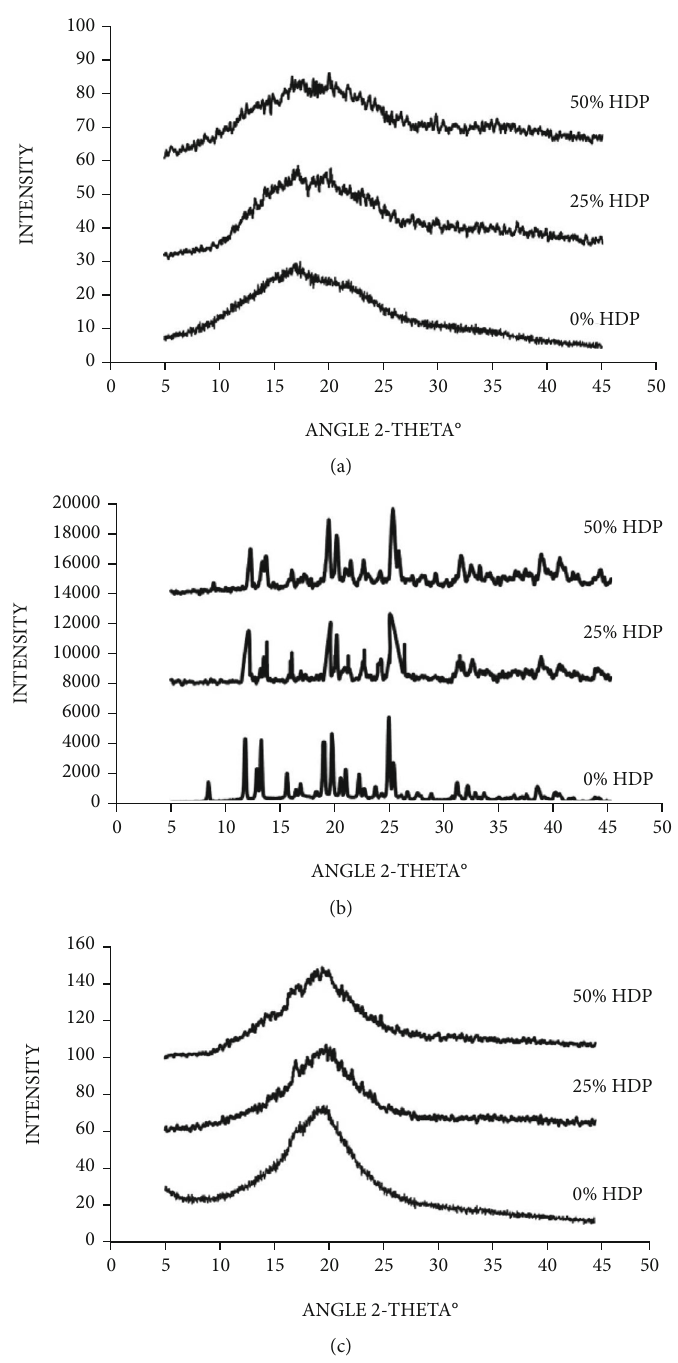
Figure 2: X-ray di ff ractograms of the starch gels in water (a), 45 ° Bx sucrose solution (b), or coconut milk (c) after storage at 4oC for 21 days. The gels were prepared with the starch blends containing di ff erent levels of HDP substitution as shown in Table